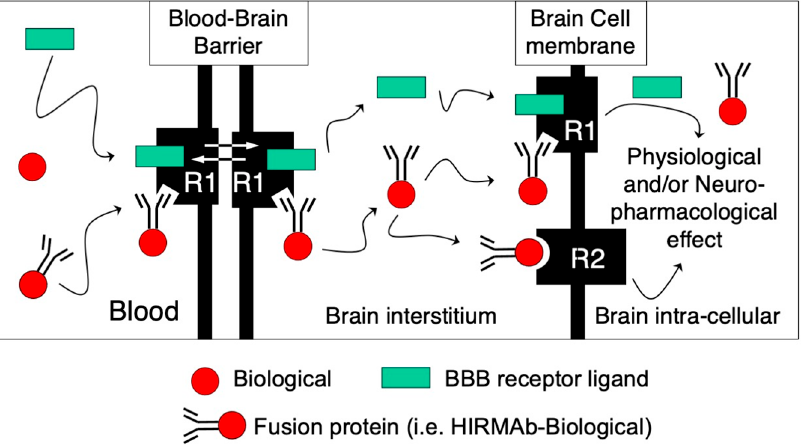
Figure 1. Receptor-mediated transport of IgG fusion proteins across the BBB. Biologicals (red circle) do not cross the BBB and stay in circulation following IV administration, as in the case of enzymes, MAbs, decoy receptors, and/or neurotrophic factors. These potential therapeutic agents for the CNS can be re-engineered as fusion proteins with an MAb targeting a BBB receptor that induces receptor-mediated transcytosis (R1), such as the human BBB insulin receptor (HIR) or the transferrin receptor (TfR). The transport domain of the IgG fusion protein targets the BBB R1 endogenous receptor to gain access to the brain. The transport MAb binds to an exofacial epitope of the receptor without interfering with the normal transport of its endogenous ligand (green rectangle) to gain access to the brain. Depending on the therapeutic domain of the IgG fusion protein, it can (i) bind to its ligand in the brain interstitial compartment, as in the case of bispecific MAbs or decoy receptors; (ii) target a brain cell membrane receptor (R2), such as neurotrophic factors; or (iii) be endocytosed via the same targeted R1 receptor in brain cells as lysosomal enzymes to produce physiological and/or neuropharmacological effect.